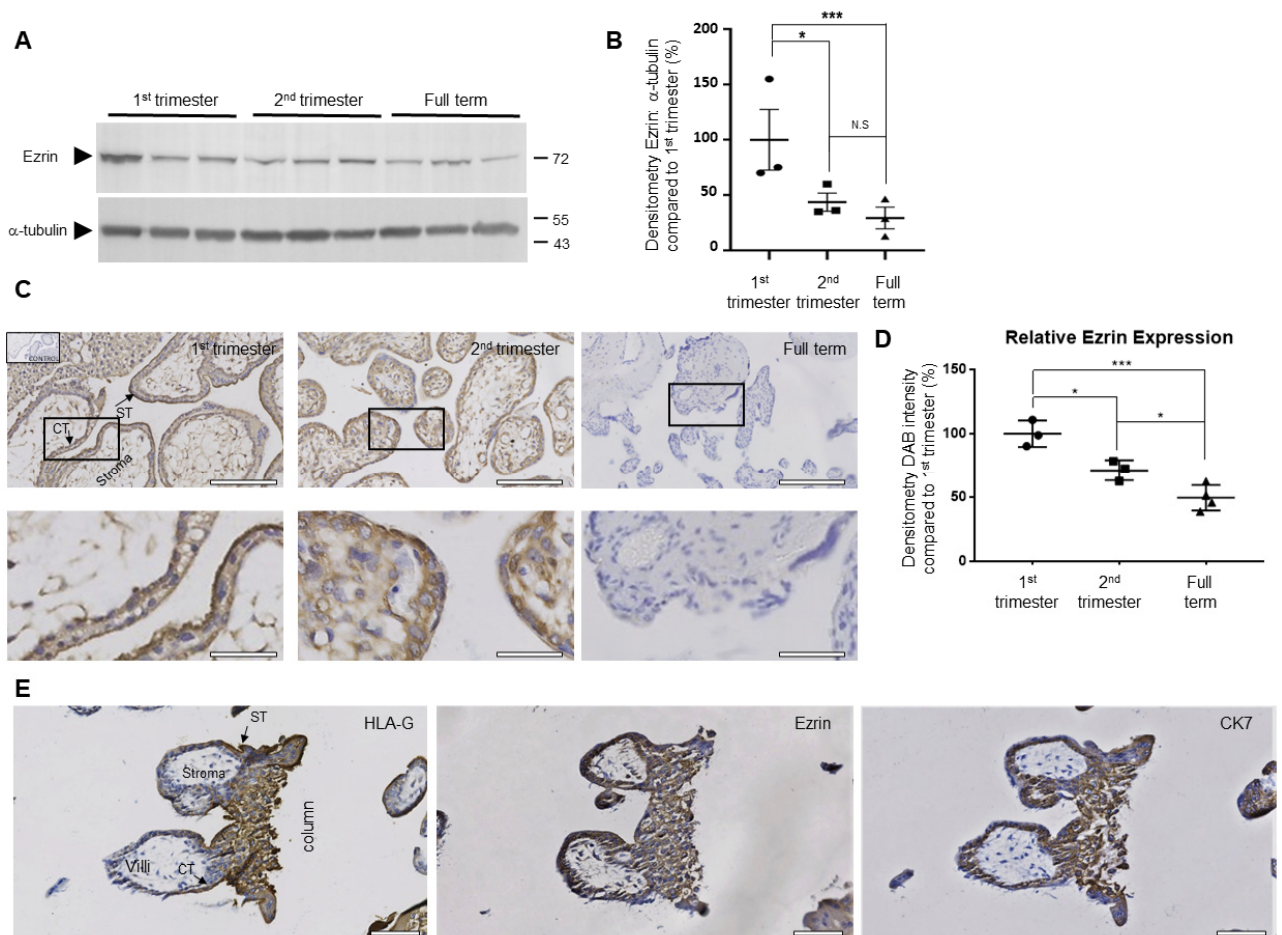
Figure 1. Ezrin is expressed in trophoblasts, including extravillous trophoblasts and anchoring columns during the first trimester in human placental tissues. Expressions of ezrin proteins were analysed on both lysates ( A , B ) and paraffin-embedded placental sample sections ( C , E ) obtained from different gestational periods (first trimester ( n = 3), second trimester ( n = 3), or full term ( n = 4)). Protein lysates of equal loading were separated by SDS-PAGE electrophoresis and transferred onto PVDF membranes before Western blotting for ezrin or α -tubulin, and cropped images are presented ( A ). Levels of ezrin were measured by densitometry analysis after Western blotting and normalised to α -tubulin for all samples. Data are presented as percentage means ± SEM of 2 independent experiments compared to the first trimester ( B ). Immunohistochemistry staining using either ezrin ( C ) or a panel of trophoblast marker antibodies (HLA-G as well as cytokeratin 7 (CK7)) as well as ezrin ( E ) were also counterstained as described in the methods section. Images for ( C ) show the overall structures of the placental sections with enlarged sections corresponding to the focused regions of the highlighted cells. Bar corresponds to 150 µ m in the wide views and 25 µ m in the zoomed-in regions. Images of anchoring columns of serial human placental tissues are also presented ( E ). Bar corresponds to 100 µ m. Arrows indicate cytotrophoblast cells (CT); syncytium (ST) and stroma are also highlighted ( C , E ). The quantification of ezrin DAB staining and intensity in the 1st, 2nd, and full-term sections ( D ). Data of an individual representative experiment are presented as the mean values ± SD of 3 independent samples ( D ). Statistical analysis ( B , D ) shows ± SD compared to the first-trimester samples of an individual representative experiment. * p < 0.05 and *** p < 0.001 (one-way ANOVA); N.S.: not